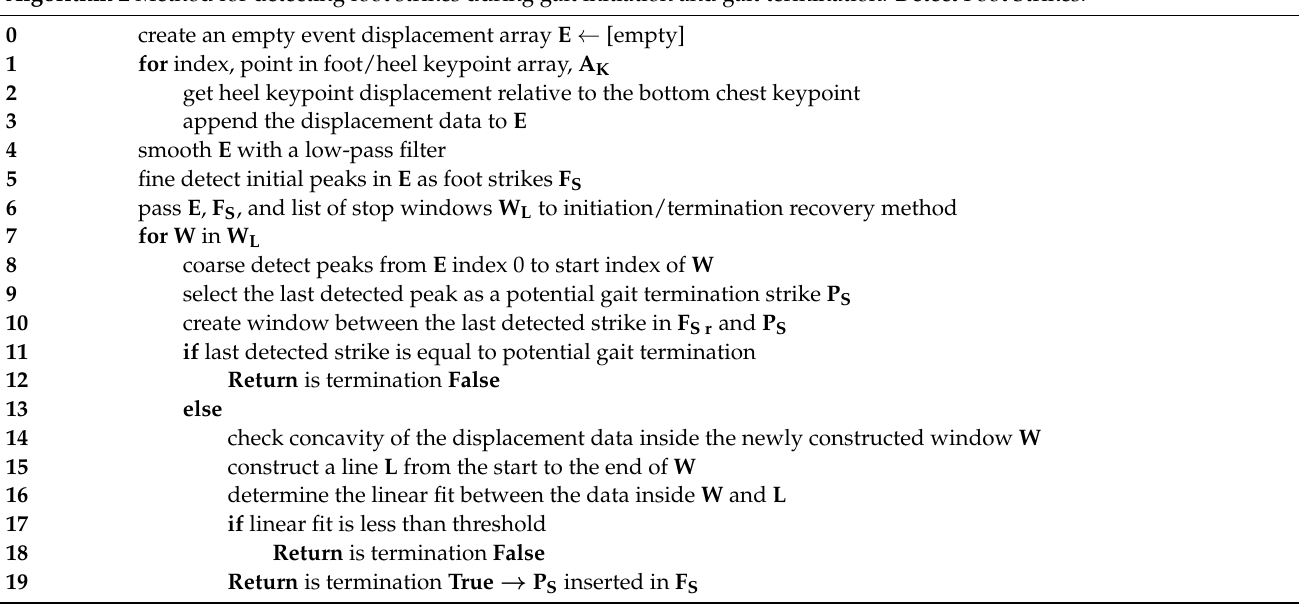
Algorithm 2 Method for detecting foot strikes during gait initiation and gait termination. Detect Foot Strikes.